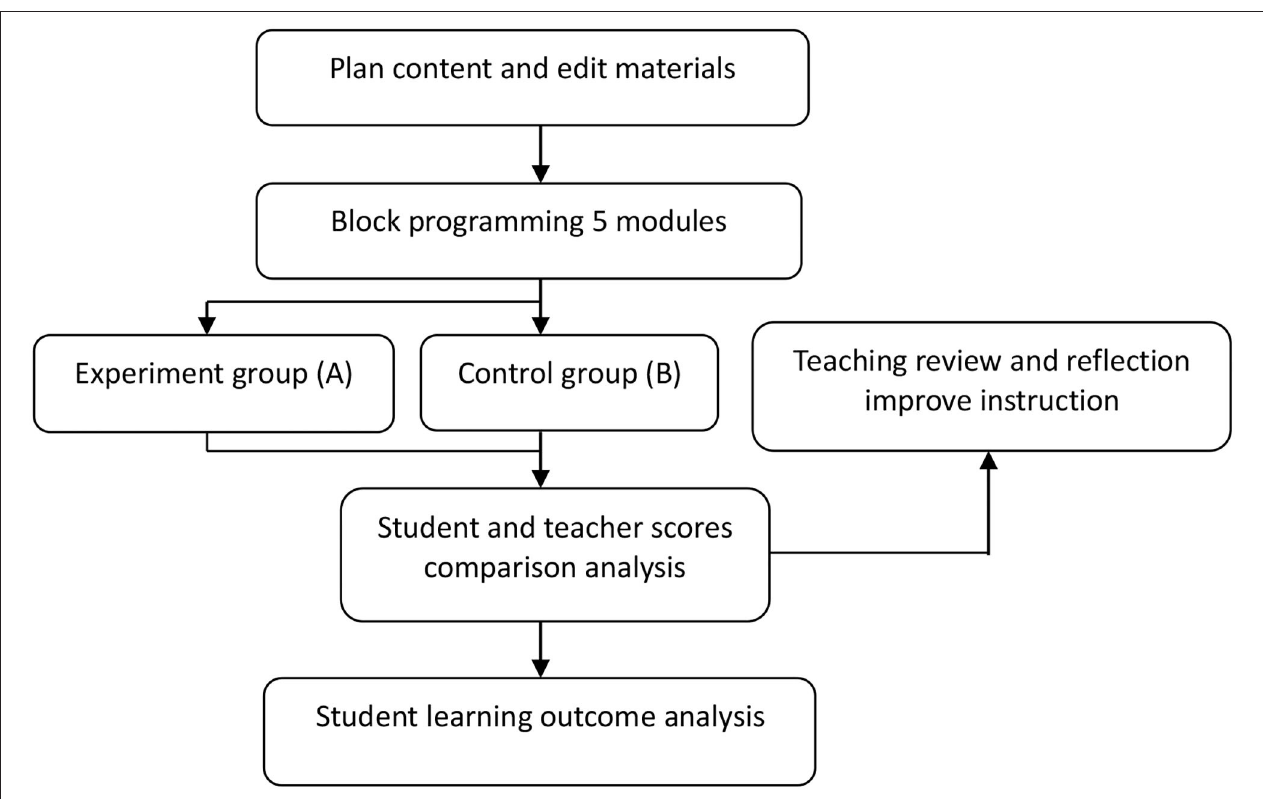
FIGURE 1 | Conceptual framework.